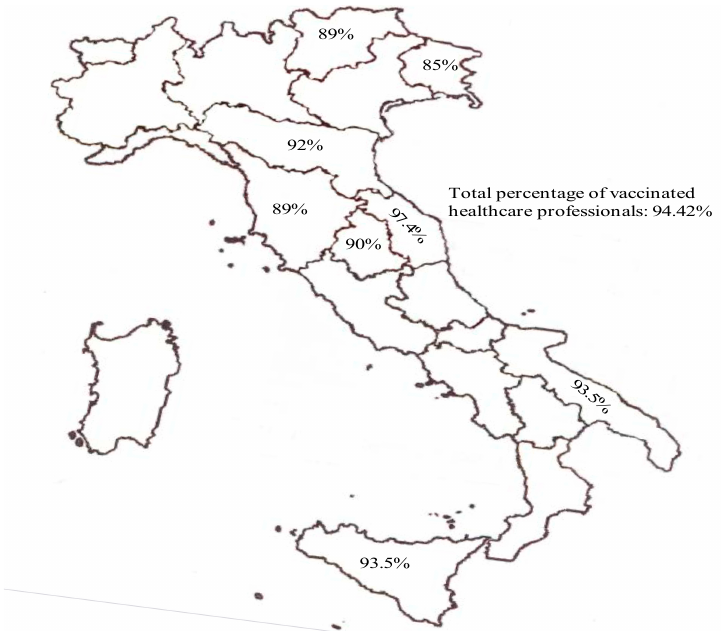
Figure 1. The picture shows single rate of vaccinated healthcare professionals for each region (data communication are incomplete for many regions). Data from Istituto Superiore di Sanità (ISS) are updated to 11 August 2021. Table 3. Vaccination coverage in the Italian population aged >12 years and COVID-19 cases diagnosed in the last 30 days, by vaccination status and age group (produced by the Istituto Superiore di Sanità (ISS), Rome. Data updated to 23 July 2021). Group Age Group Unvaccinated People Single Dose Complete Cycle